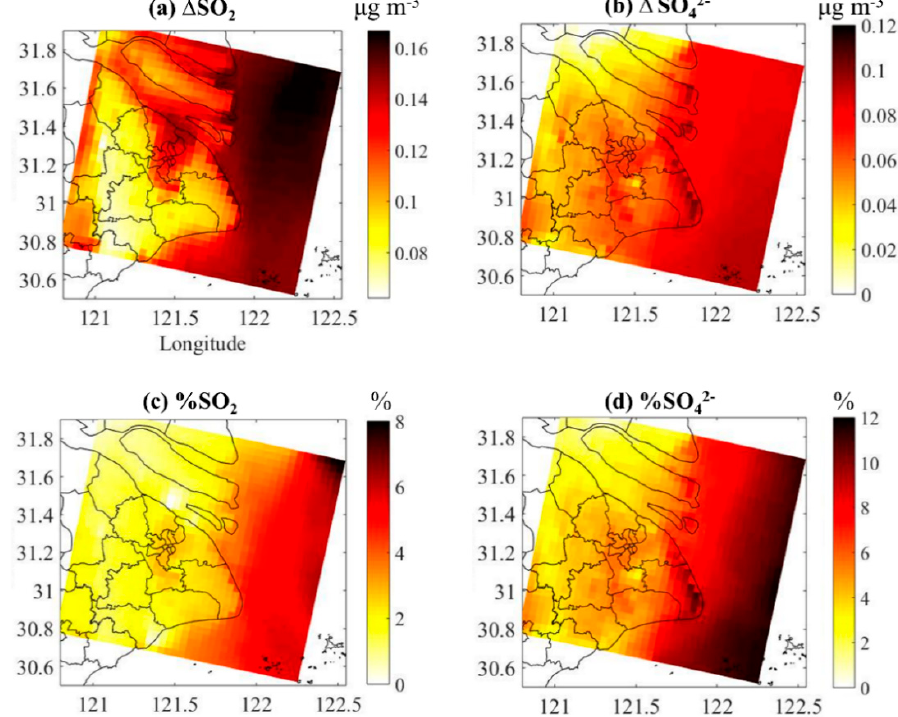
Figure 7. The absolute contribution of DMS to the annual average concentration of ( a ) SO 2 and ( b ) SO (cid:2872)(cid:2870)(cid:2879) , and the relative contribution of DMS to the annual average concentration of ( c ) SO 2 and ( d ) SO (cid:2872)(cid:2870)(cid:2879) in Shanghai.